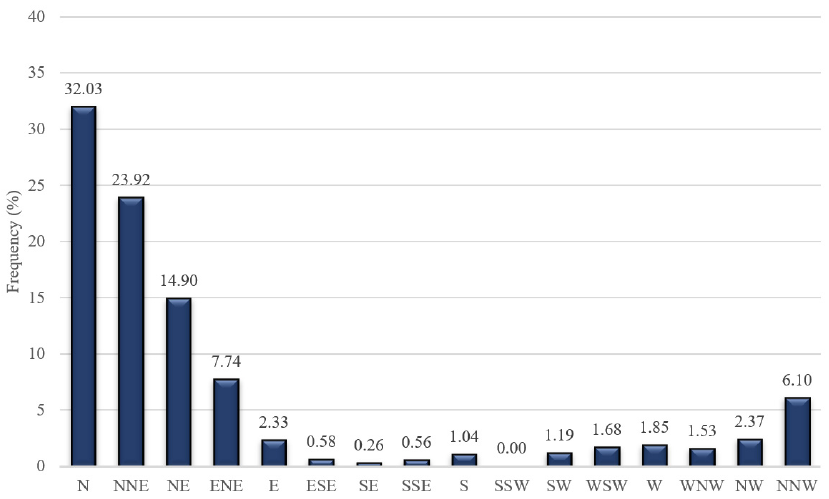
Figure 6. Porto Santo’s waves propagation direction. (Source: Authors).